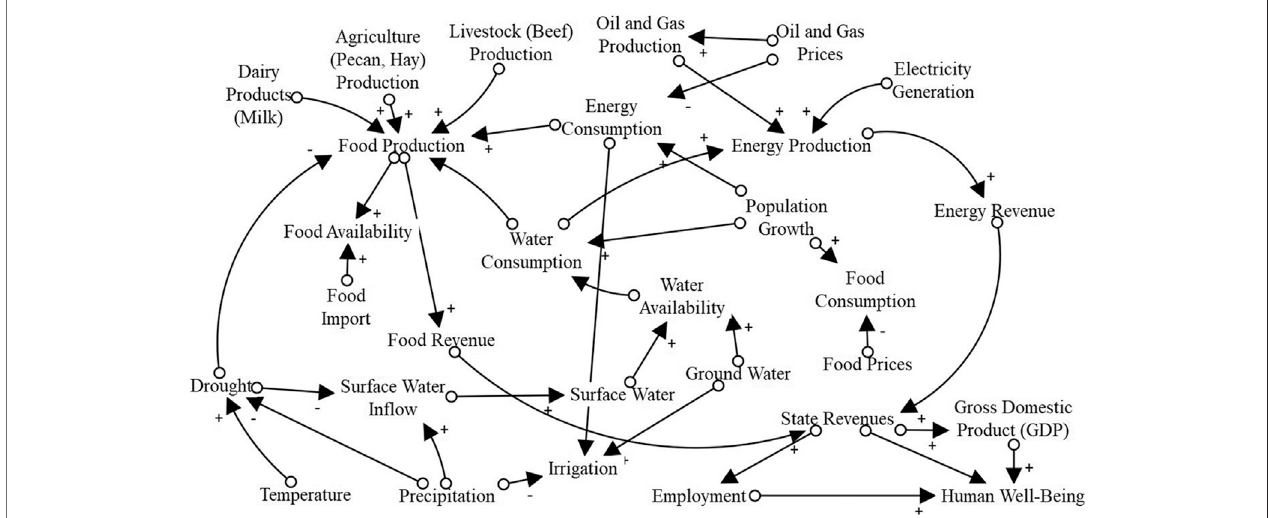
FIGURE 11 | Casual loop diagram for NM ’ s FEW systems. The arrows describe cause-and-effect behavior between variables. For example, an arrow from A to B indicates that A causes B. Pair-wise variable polarities represented as positive (+) (i.e., an increase or decrease in one factor causes an increase or decrease in the other factor) or (-), which is the opposite of a positive in fl uence (i.e., an increase or decrease in one factor causes a decrease or increase in the